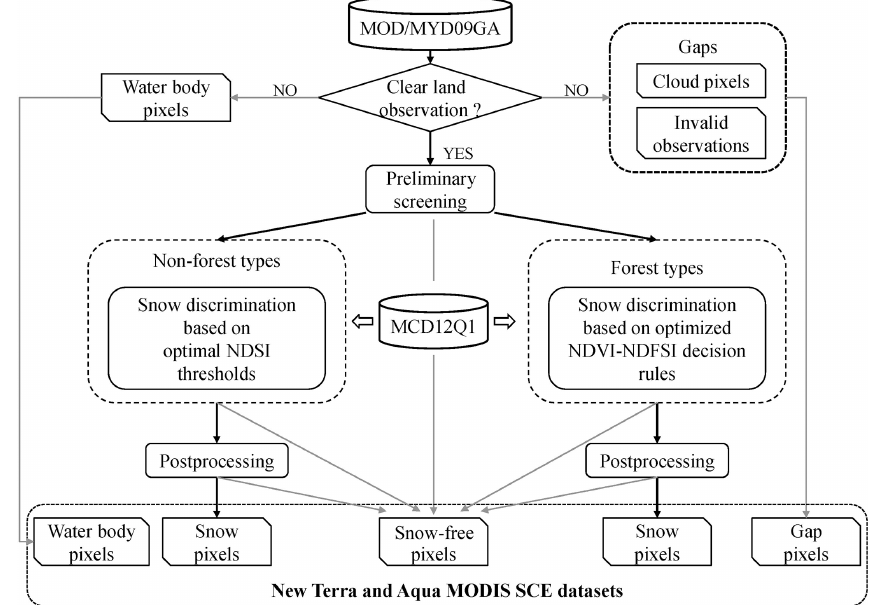
Figure 1. Flowchart of the new snow discrimination algorithm under clear skies.